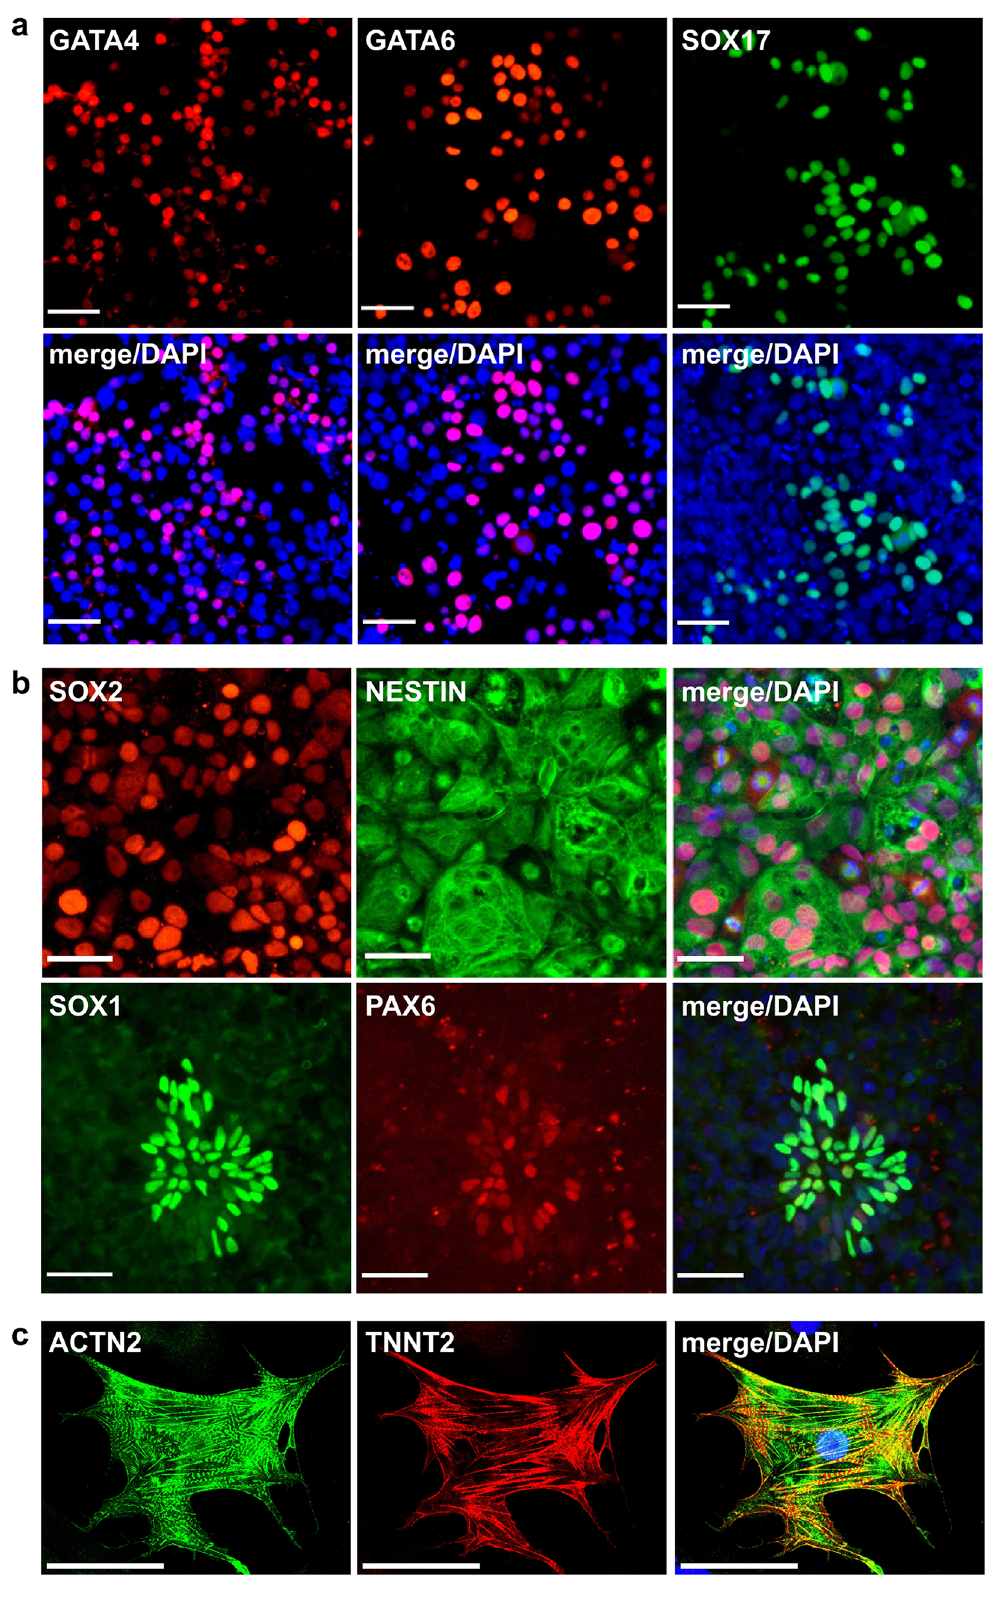
Figure 2. Three germ layer differentiation potential of NWR iPSCs. See also Supplementary Fig. S3, Supplementary Movie M1. Representative immunostainings for markers of the three germ layers upon differentiation of NWR iPSCs towards endoderm ( a ), neural precursors (ectoderm, ( b )), and cardiomyocytes (mesoderm, ( c )). Scale bars: 50